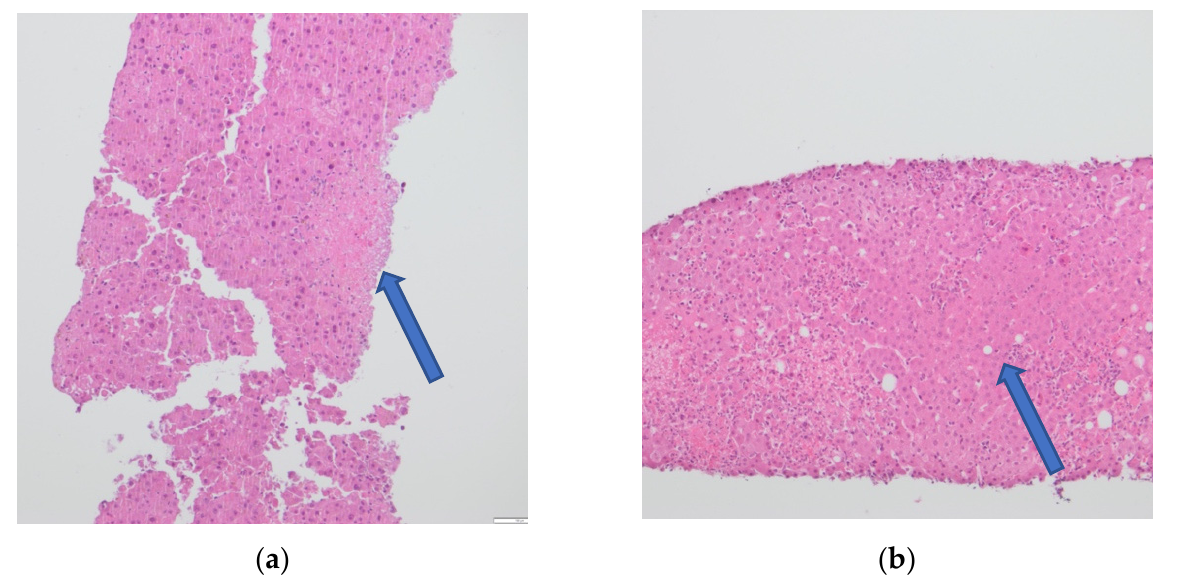
Figure 2. Liver biopsy (10× enlarged) in hematoxylin–eosin staining of ( a ) case 1 showing a multifocal, hepatocellular necrosis and viral inclusion bodies, and ( b ) case 2 showing an acute and extensive hepatocellular necrosis.